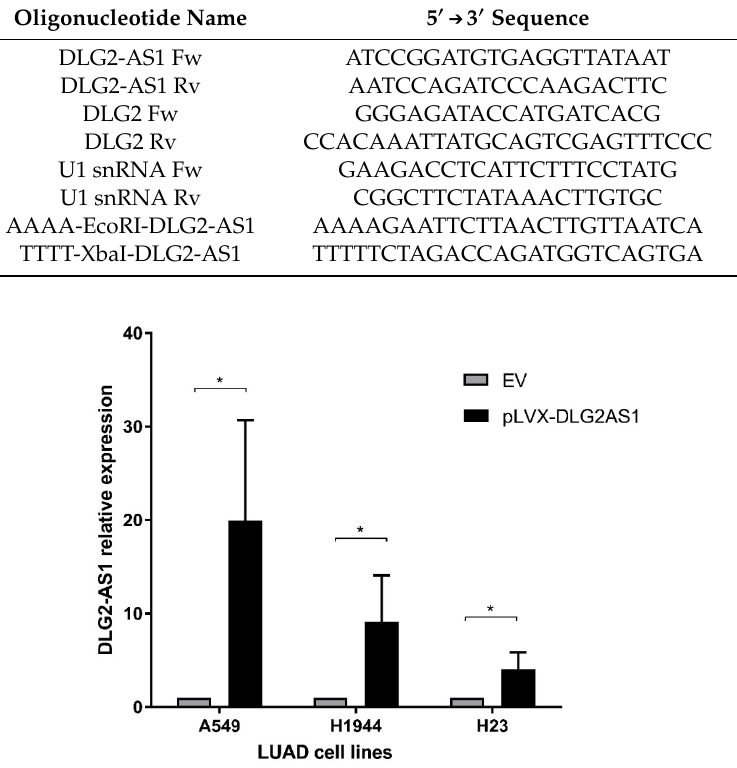
Figure A1. DLG2-AS1 restoration model on lung adenocarcinoma (LUAD) cell lines successfully overexpresses DLG2-AS1. DLG2-AS1 relative expression was measured by RT-qPCR 5 days after transfection, and normalized by the expression of the reference gene U1 snRNA. In all three cell lines tested, DLG2-AS1 was successfully overexpressed (relative expression (pLVX-DLG2AS/EV) > 2). * = p -value < 0.05.